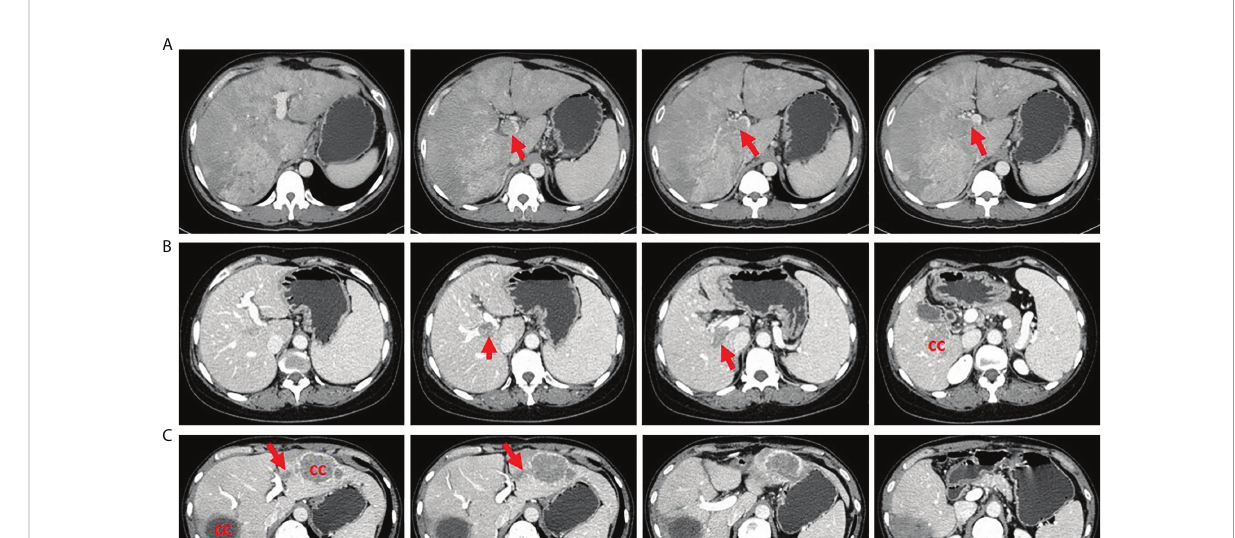
FIGURE 1 Study fl ow